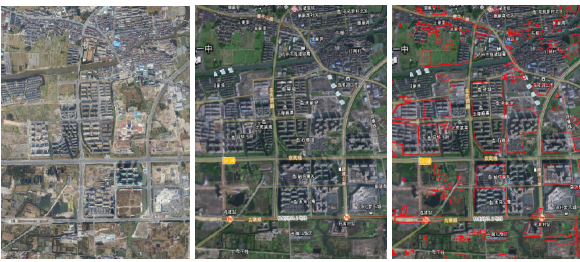
Fig. 7 Images in the pilot area in 2017 & 2018 and inconsistencies extraction 2.3.3 Video-based Architectural Inconsistent Information Automatic Extraction